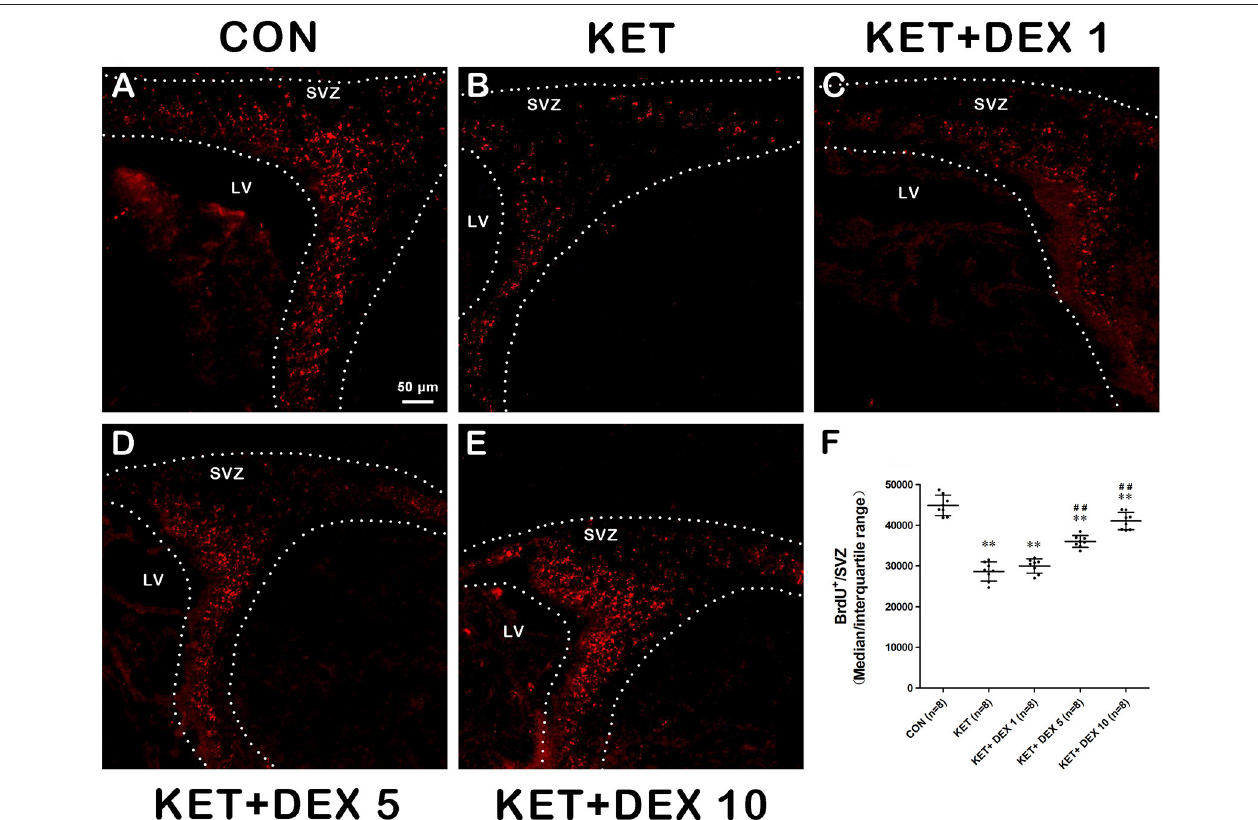
FIGURE 1 | The effects of ketamine (KET) and dexmedetomidine (DEX) on the proliferation of neural stem cells (NSCs) in the SVZ. Neonatal rats were pretreated with different doses of DEX via intraperitoneal injection prior to ketamine anesthesia for 30min. (A–E) Representative images of NSC proliferation (BrdU staining, red) were captured using a laser scanning confocal microscope (magnification × 200, scale bar: 50 µ m). (F) The number of BrdU + cells per SVZ in the different groups is shown. Data are presented as the means ± SD (eight tissue sections per group). ** p < 0.01 compared with the Control group; ## p < 0.01 compared with the KET group. SVZ, subventricular zone; LV, lateral